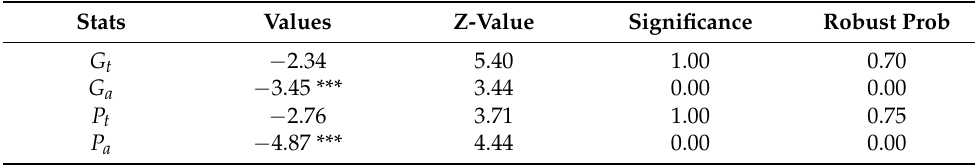
Table 6. Westerlund co-integration